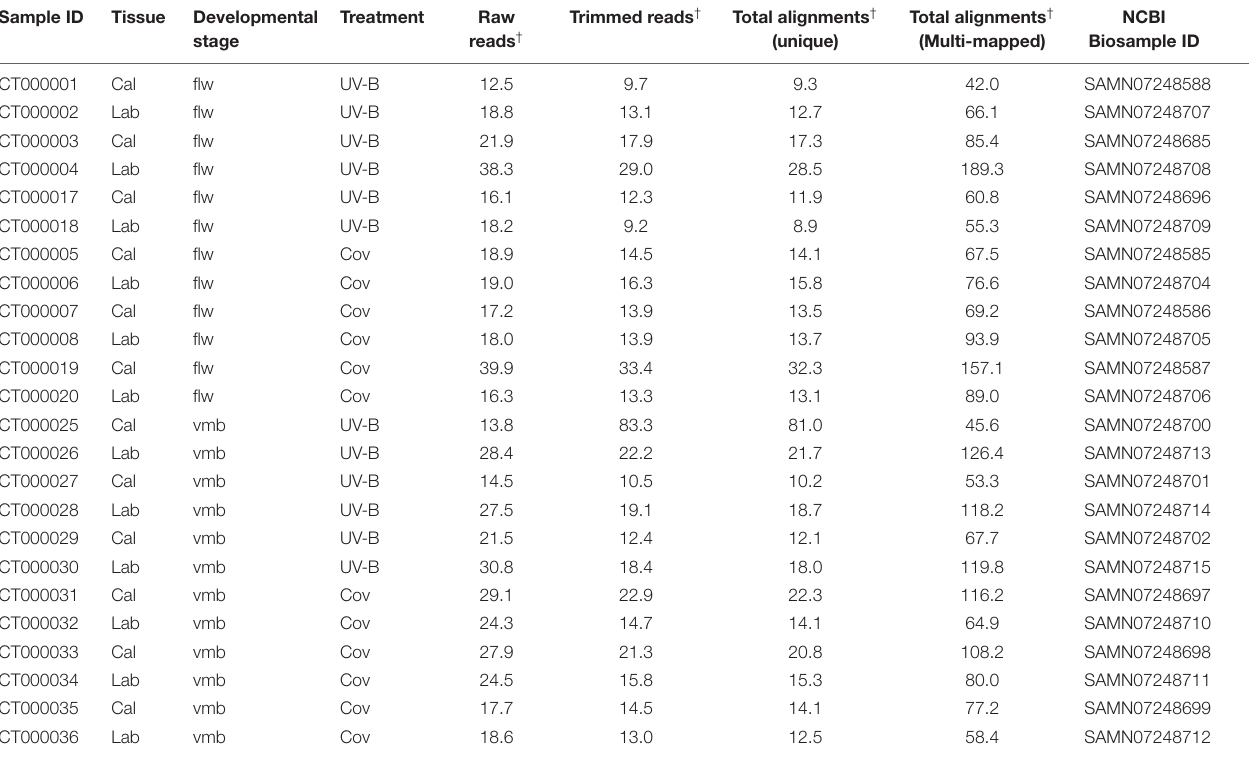
TABLE 1 | Summary of RNA sequencing analysis